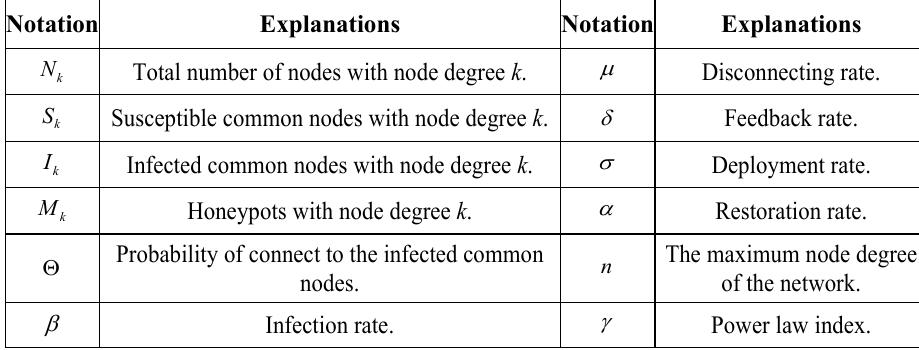
Table 1. Notation and explanations for the proposed